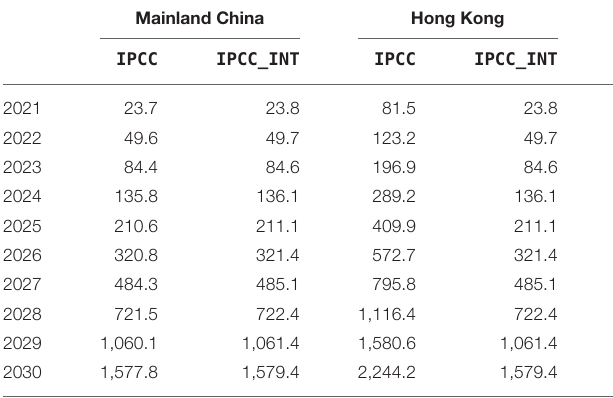
TABLE 7 | Carbon prices under stringent mitigation